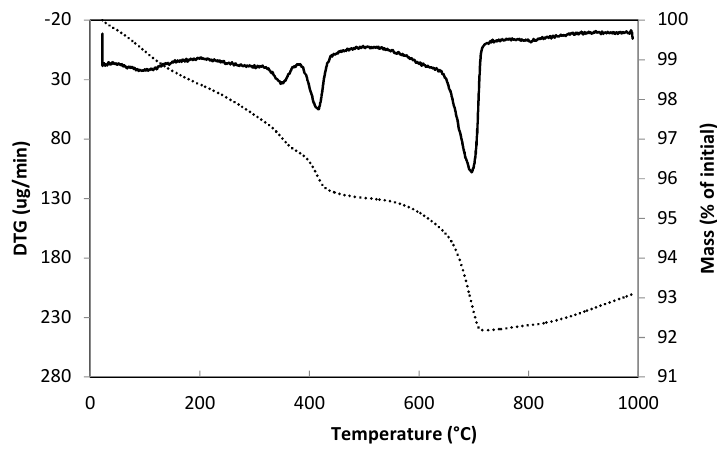
Figure 3. TG (dotted line) and DTG (solid line) diagrams of the BOF slag.